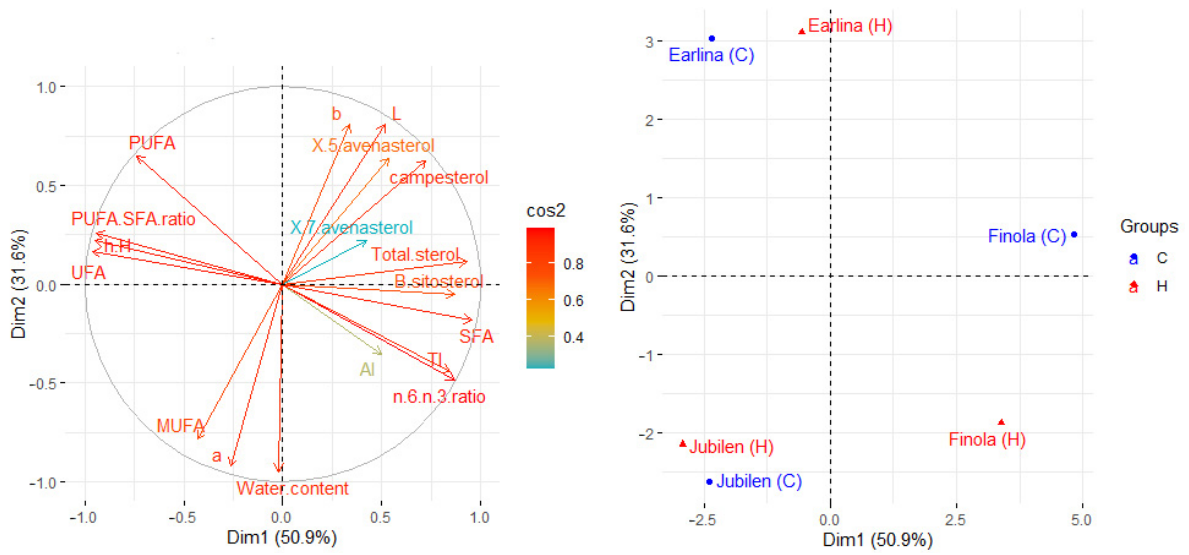
Figure 1. Principal component analysis (PCA) of the loadings plot and the score plot of data from fatty acid groups (SFA, UFA, MUFA, PUFA), PUFA/SFA ratio, n-6/n-3 ratio, Atherogenicity Index (AI), hypocholesterolemic/Hypercholesterolemic Index (h/H), Thrombogenicity Index (TI), phytosterols, color and water content of hemp oils.